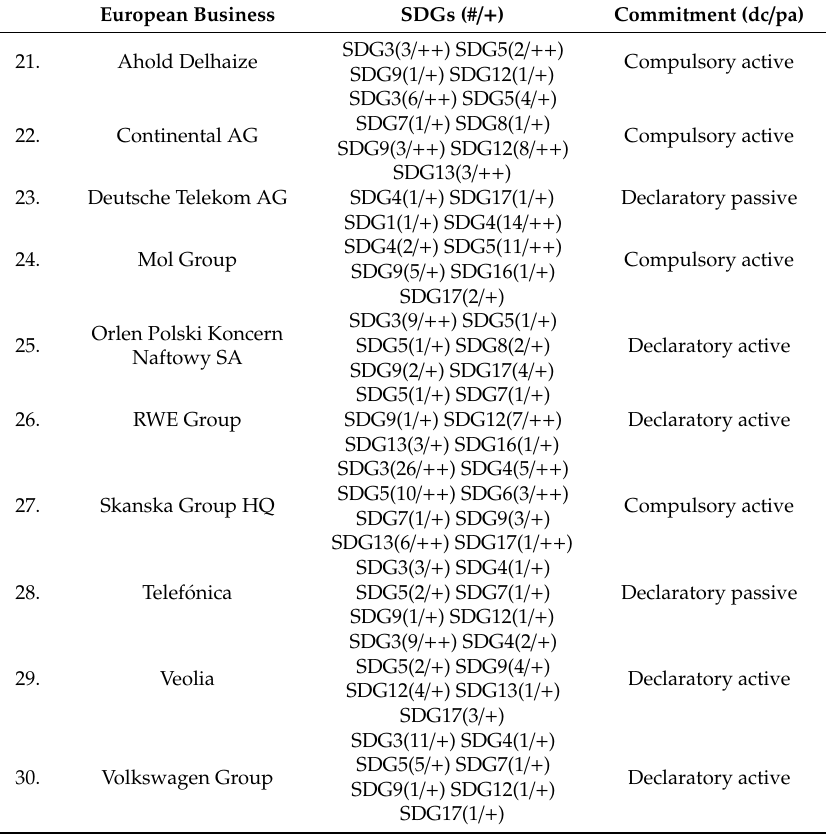
Table 6. Case study—second group. Case study included SDGs, their frequency (#) and score ( + ), and their actionability (declaratory vs. compulsory) and nature (passive vs.